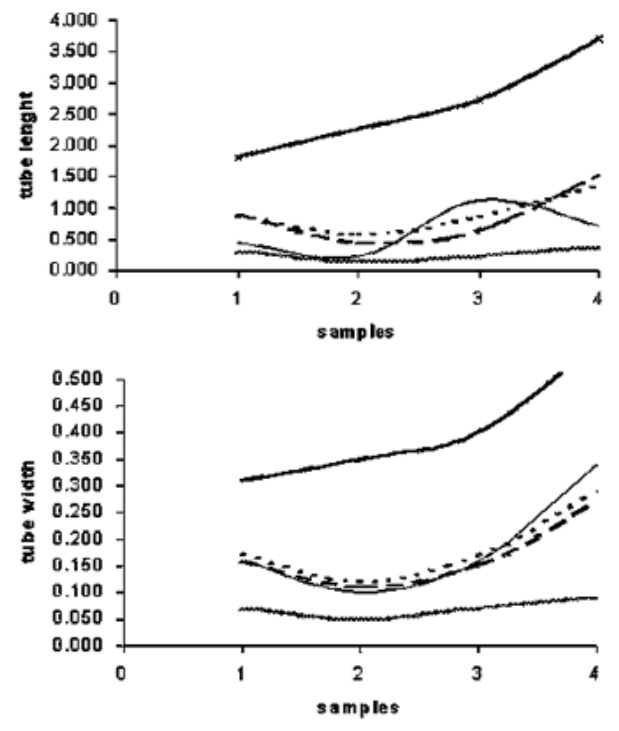
Fig. 10 – Maximum (upper line), mean (dotted line), mode (fine line), median (dashed line) and minimum (lower line) tube lengths and the same statistic values of tube widths of samples 1 (Ce1), 2 (Ce2), 3 (Ce9), and 4